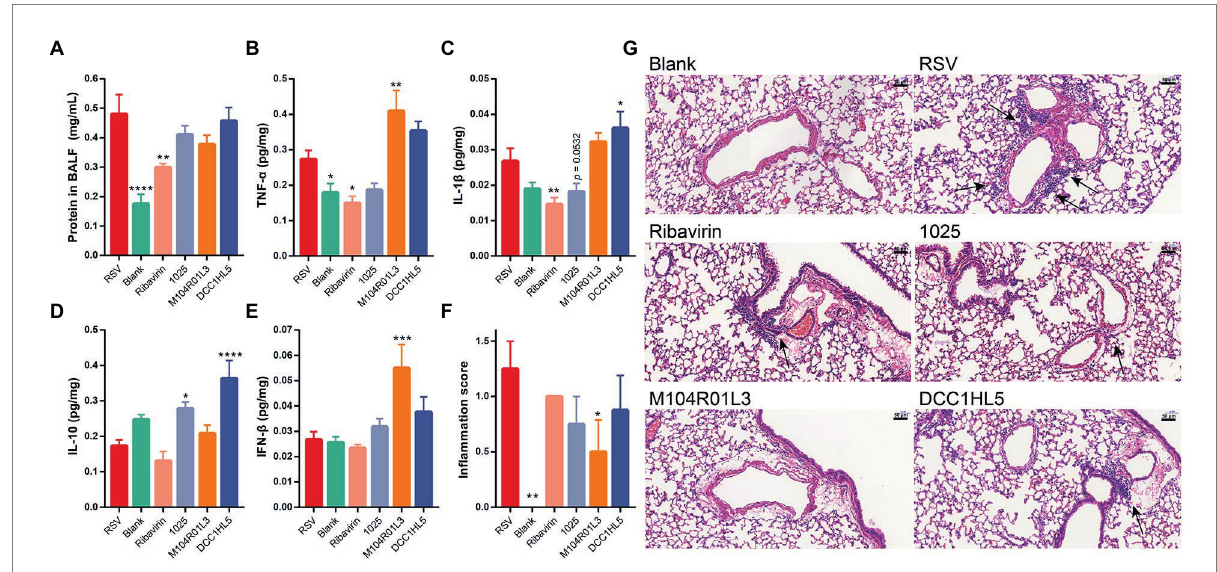
FIGURE 3 Impact of three Lactobacillus mucosae strains on cytokine levels and lung damage. Levels of (A) total protein in BALF, (B) TNF- α in lung tissues, (C) IL-1 β in lung tissues, (D) IL-10 in lung tissues, and (E) IFN- β in lung tissues. (F) Inflammation scores of lung tissues ( n = 4). (G) Lung sections stained with hematoxylin and eosin. Arrows, perivascular inflammatory infiltration. Original magnification ×400. ( n = 8, except (F); * p < 0.05, ** p < 0.01, *** p < 0.001, **** p < 0.0001 vs. RSV group). Error bars show the means ± standard error of the mean (SEM). Differences were compared using one-way ANOVA, followed by Fisher’s LSD test. P -values were adjusted using a false discovery rate. Blank, not infected with RSV. RSV, infected with respiratory syncytial virus and